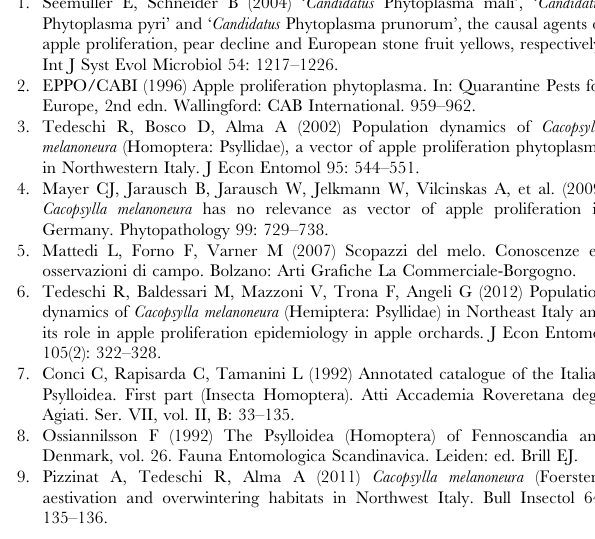
Table S1 Genetic variability at seven microsatellite loci for Cacopsylla melanoneura samples. Table S2 Matrix of Slatkin’s linearized FST values for all population